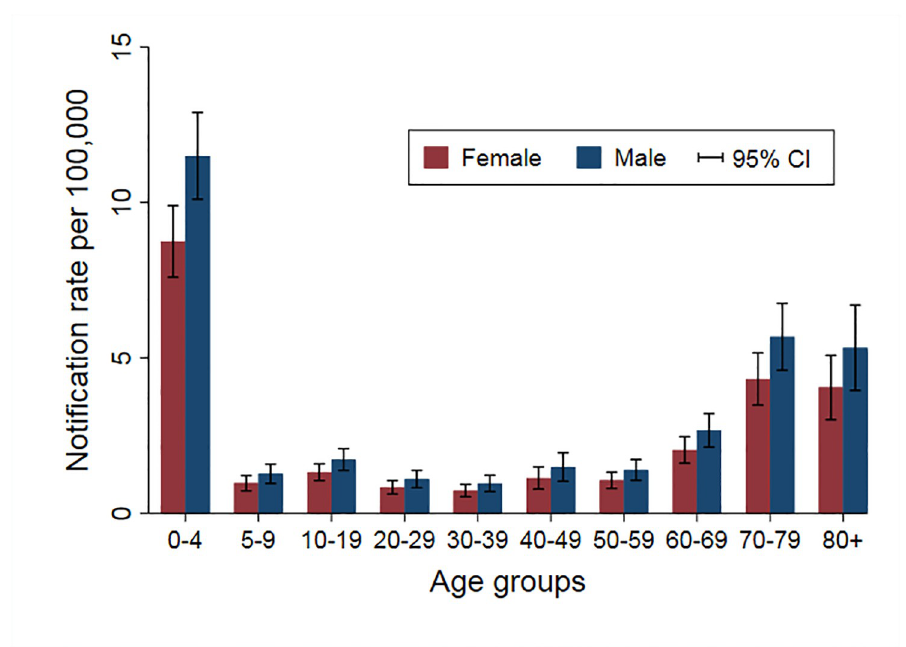
Fig 4. Adjusted notification rates of iNTS disease in Queensland by gender and age group, 2007–2016.